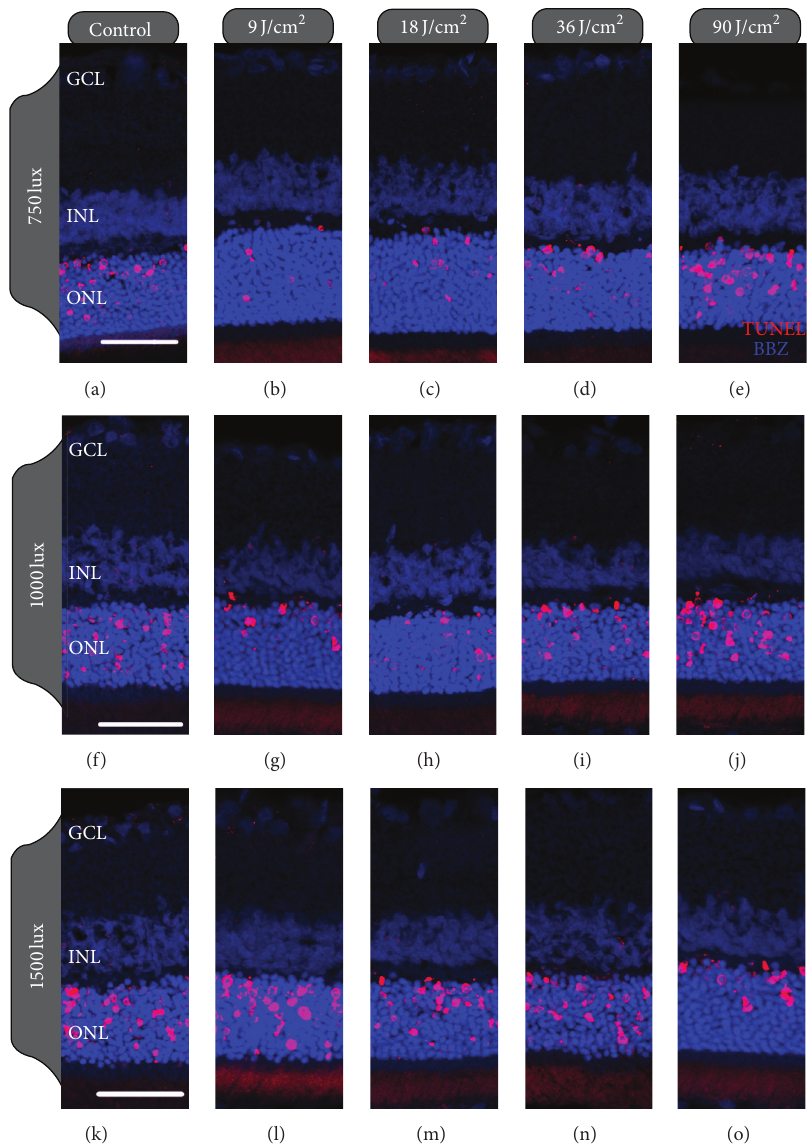
Figure 2: Representative images of the effects of 670 nm light treatment on photoreceptor cell death induced by exposure to different intensities of white light. Images were all taken from the same area in the superior portion of the retina. ((a)–(e)) 750-lux light damage. TUNEL counts were highest in light damage controls with a reduction in TUNEL+ cells seen in retinas that underwent 9 and 18J/cm 2 670 nm light treatment. There were no visible changes between the control and 36 J/cm 2 treatments but an increase was seen in the 90J/cm 2 treatments. ((f)–(j)) 1000-lux light damage. Similar to the 750-lux paradigm, TUNEL counts were highest in light damage controls with a reduction in TUNEL+ cells seen in retinas that underwent 9 and 18J/cm 2 670 nm light treatment. No visible differences were seen between the control and 36J/cm 2 treatments. Treatments with a dose of 90 J/cm 2 670 nm light appeared to increase the amount of TUNEL+ cells in the ONL. ((k)–(o)) 1500-lux light damage. All retinas stained positive with a high amount of TUNEL cells with only 90 J/cm 2 treatments appearing to reduce TUNEL+ cell counts (scale bars indicate 50 𝜇 m; BBZ is a bisbenzimide